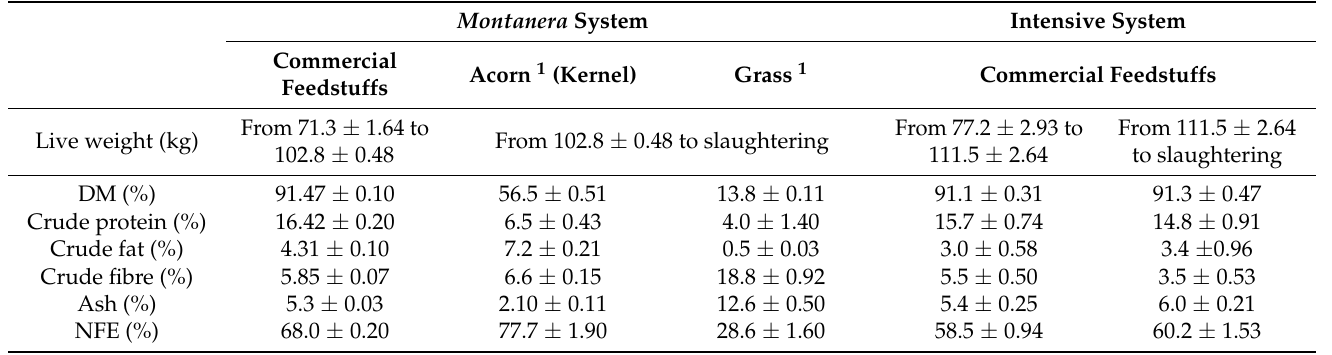
Table 1. Characterization of the commercial feedstuffs and acorn and grass provided to animals under both the Montanera and intensive production